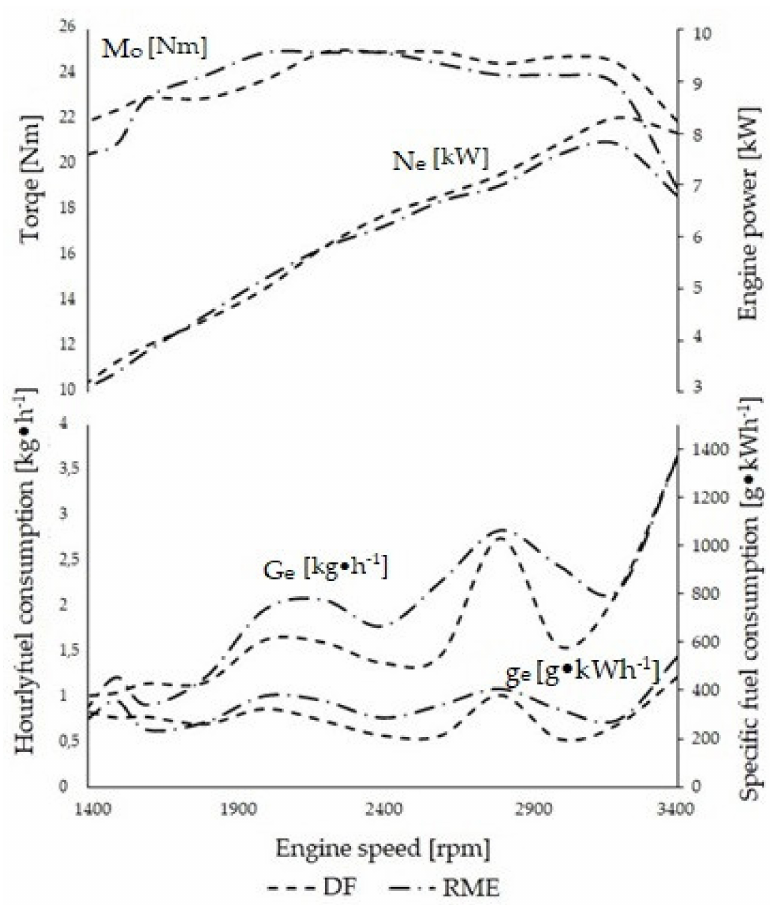
Figure 3. Characteristics of the full load of the tested engine fueled with the tested